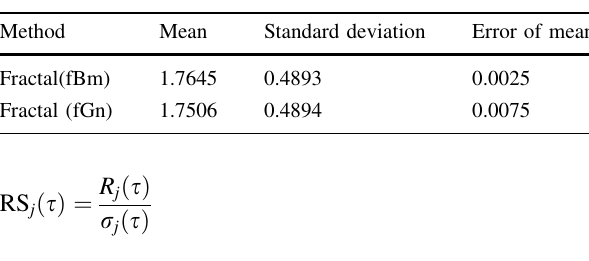
Table 10 Statistical analysis of simulated permeability distribution in well C